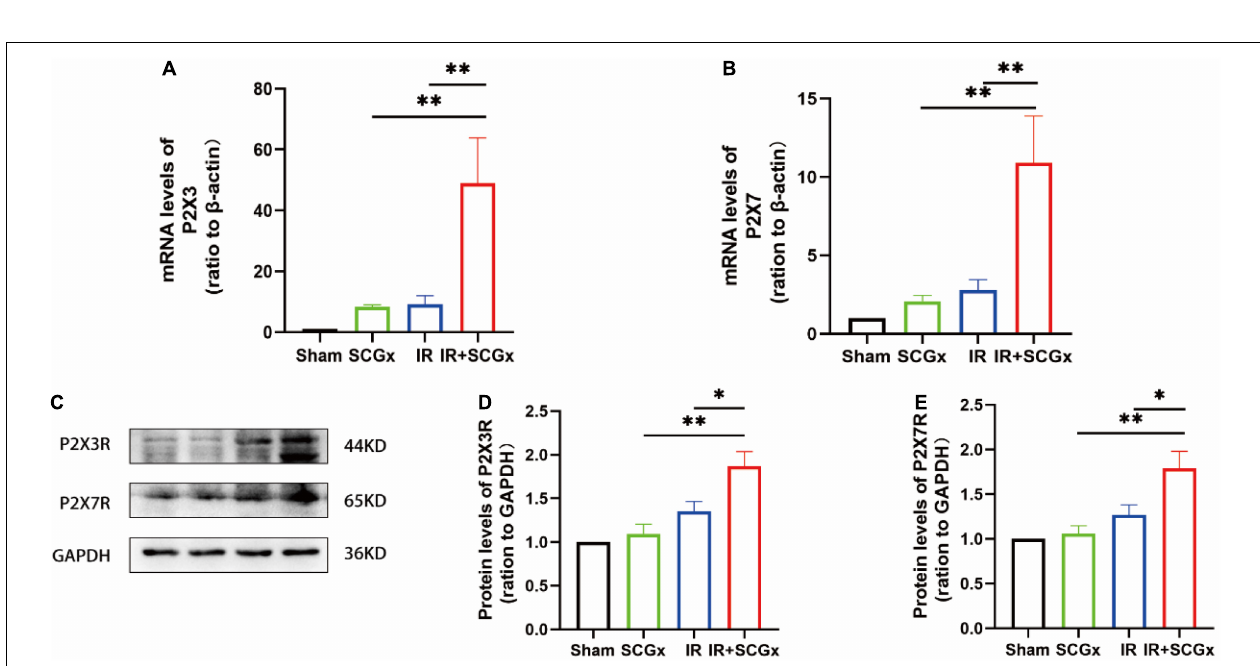
FIGURE 4 | The activated purinergic P2X receptor in the spinal cord upon sympathetic denervation. (A,B) Real-Time PCR for P2X3R and P2X7R in the spinal cord. β -actin used as internal control. (C) Representative images of protein levels of P2X3R and P2X7R. (D,E) The expression levels of P2X3R and P2X7R in the spinal cord were normalized to GAPDH within the same sample. ∗ P < 0.05; ∗∗ P < 0.01, each group contains at least 4 rats.